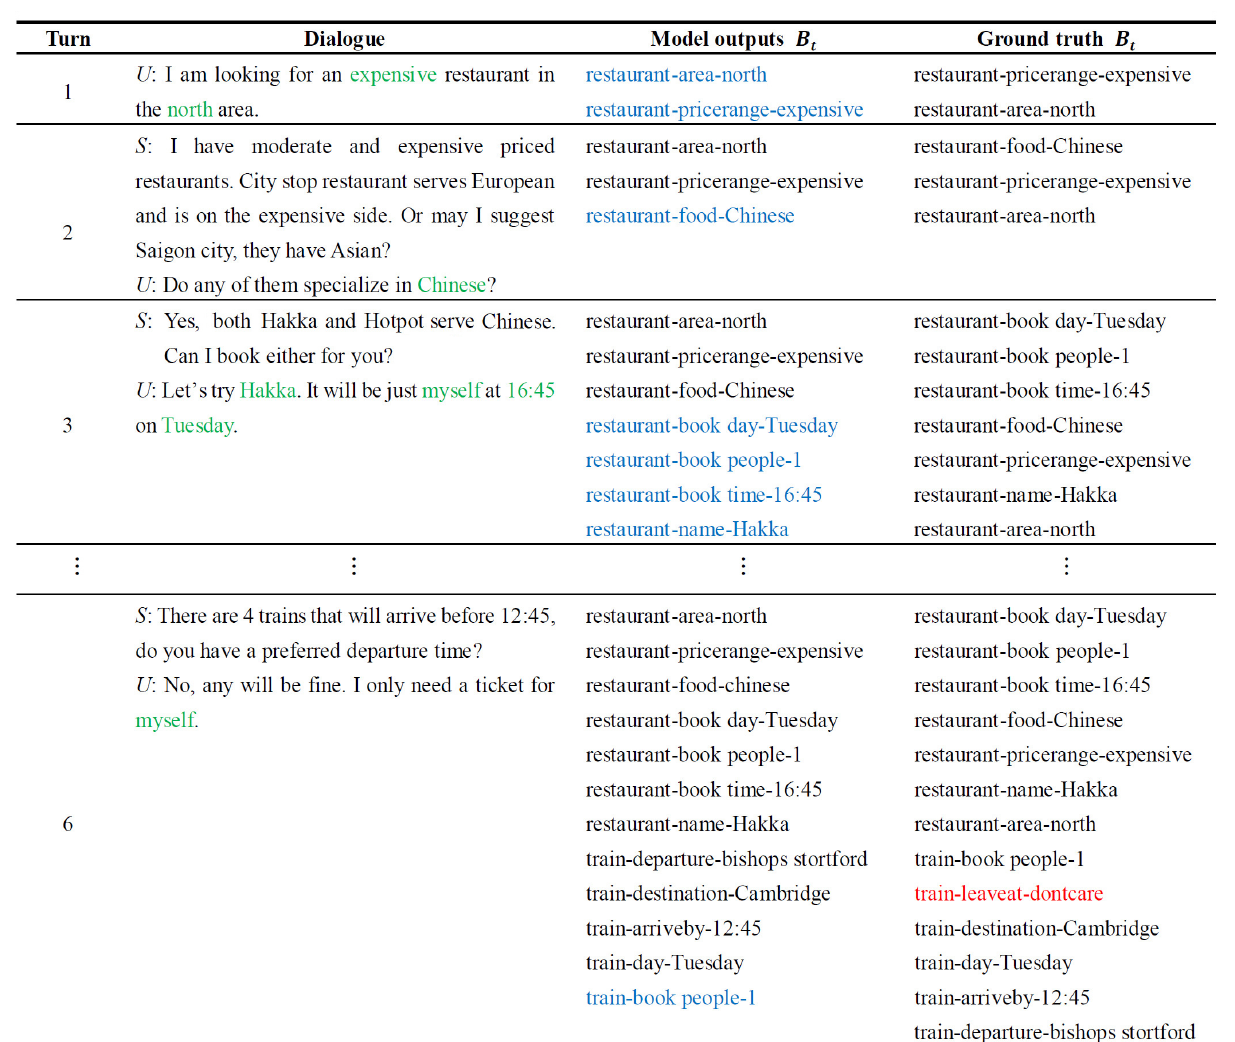
Fig. 3 Example of our model output on a dialog (dialog ID: MUL1598.json) in the test set of MultiWOZ2.1. To save space, we have omitted some parts of the dialog. The green font indicates the state that needs to be tracked. The blue font represents the state that is correctly predicted in each round. The red font indicates the false predictions or unpredicted items. Table 5 Joint goal accuracy of the ablation study on